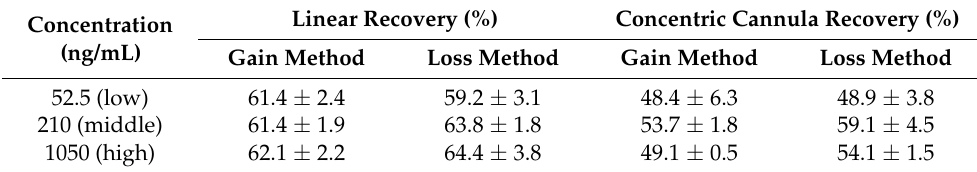
Table 1. Results of triptolide concentrations on the ex vivo recovery determined by the gain method and loss method from the linear microdialysis probe and concentric cannula microdialysis probe ( n = 5).